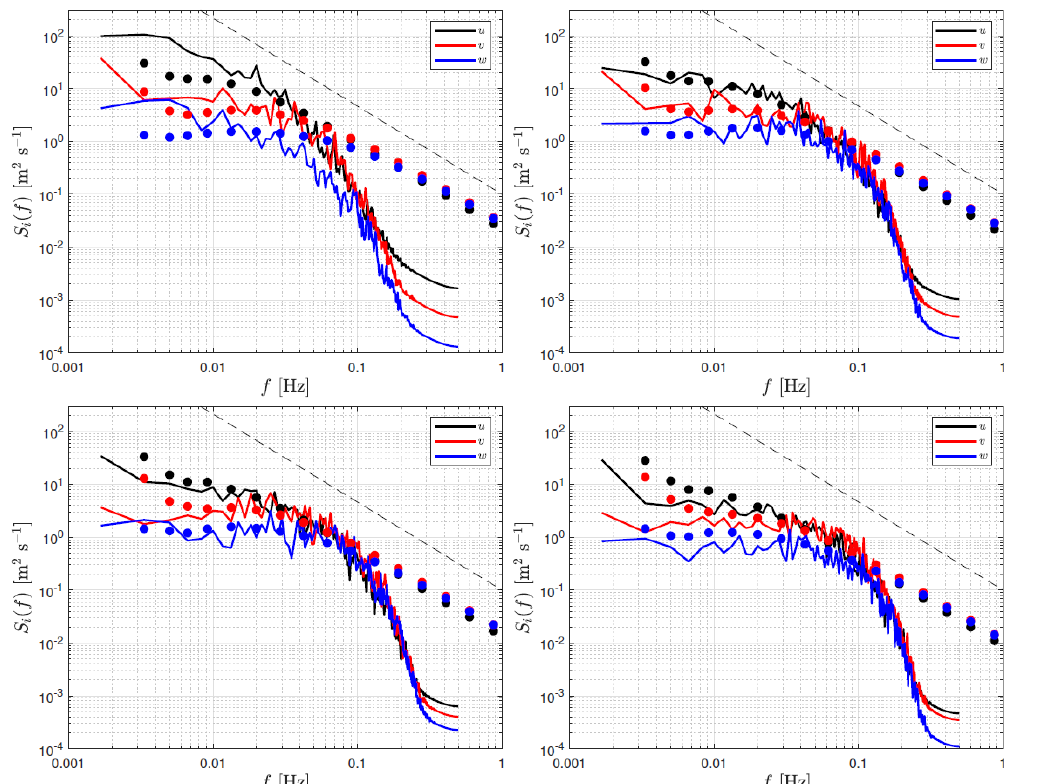
Figure 15. Similar to Fig. 9 but for stable